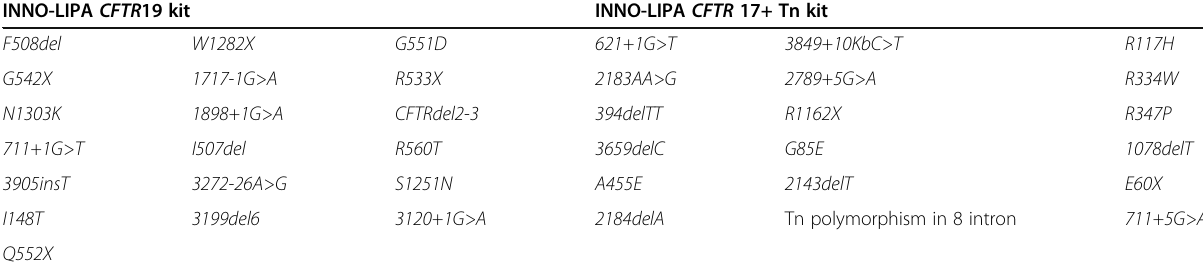
Table 1 Pathogenic variants that were analyzed by the different INNO-LIPA CFTR kits from Innogenetics, Ghent, Belgium company INNO-LIPA CFTR 19 kit